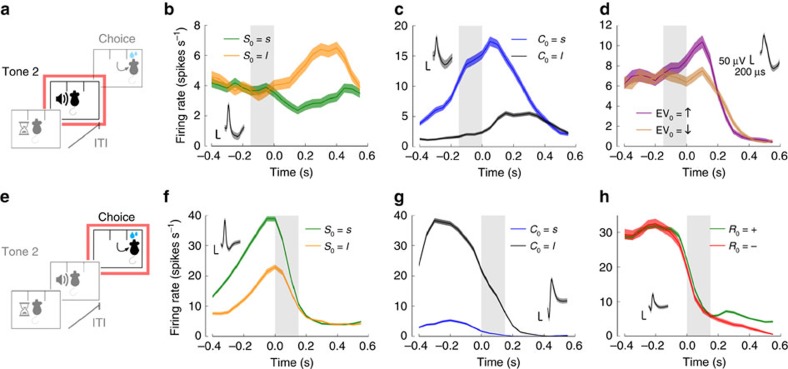
OFC neurons encode essential quantities throughout the trial.(a–d) Neuronal responses were aligned to stimulus offset (a). The firing rate of OFC neurons was modulated in a time period before stimulus offset (150 ms, shaded areas in b–d) by the stimulus (b), the upcoming choice (c) and the expected value of the outcome (d). (e–h) Neuronal responses were aligned to lateral nose poking onset, choice period (150 ms) (e). The firing rate of OFC neurons represented the stimulus (f), the current choice (g) and the outcome (h). In the two periods, signals about upcoming and current choice were very conspicuous. Time zero corresponds to stimulus offset (b–d) and lateral nose poking onset (f–h). Curves correspond to trial-averaged firing rates smoothed with a causal sliding rectangular window (size of 100 ms and step of 50 ms), and shaded areas around them correspond to s.e.m. Insets represent spike waveform for each neuron (black line, mean; shaded area, s.d.).